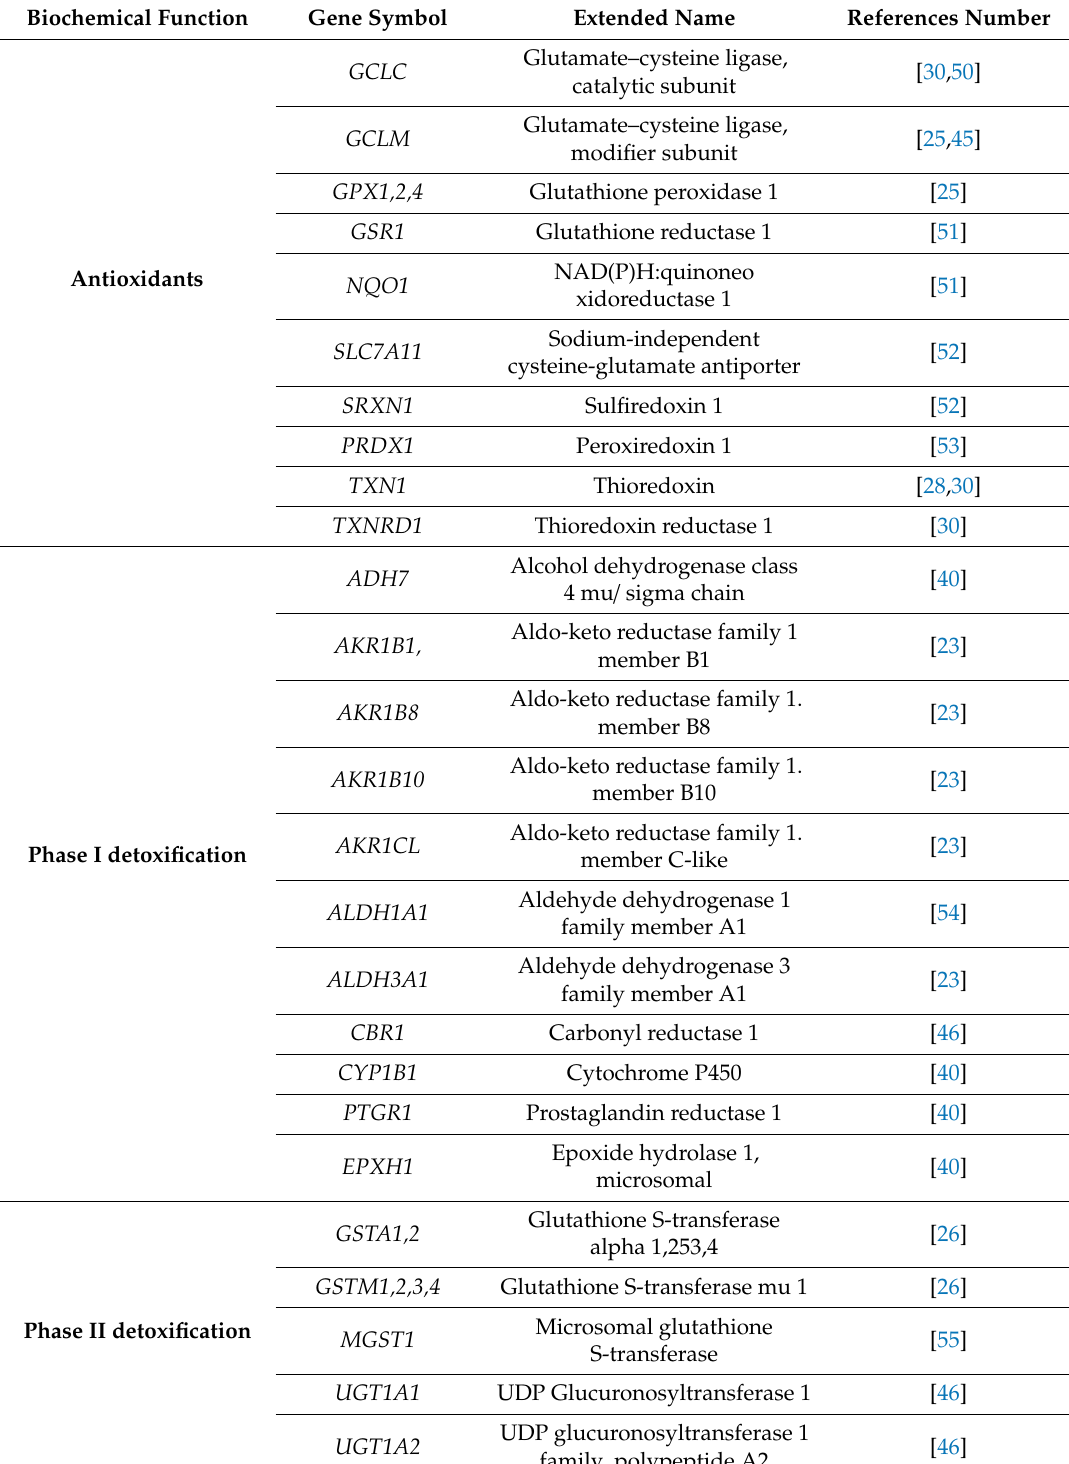
Table 1. A list of selected genes regulated by